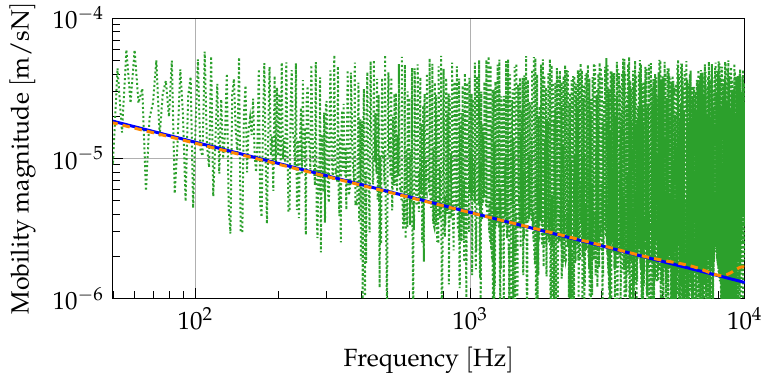
Figure 10. Point mobility of an undamped infinite free beam. Analytical mobility (28), with boundary domains, without boundary